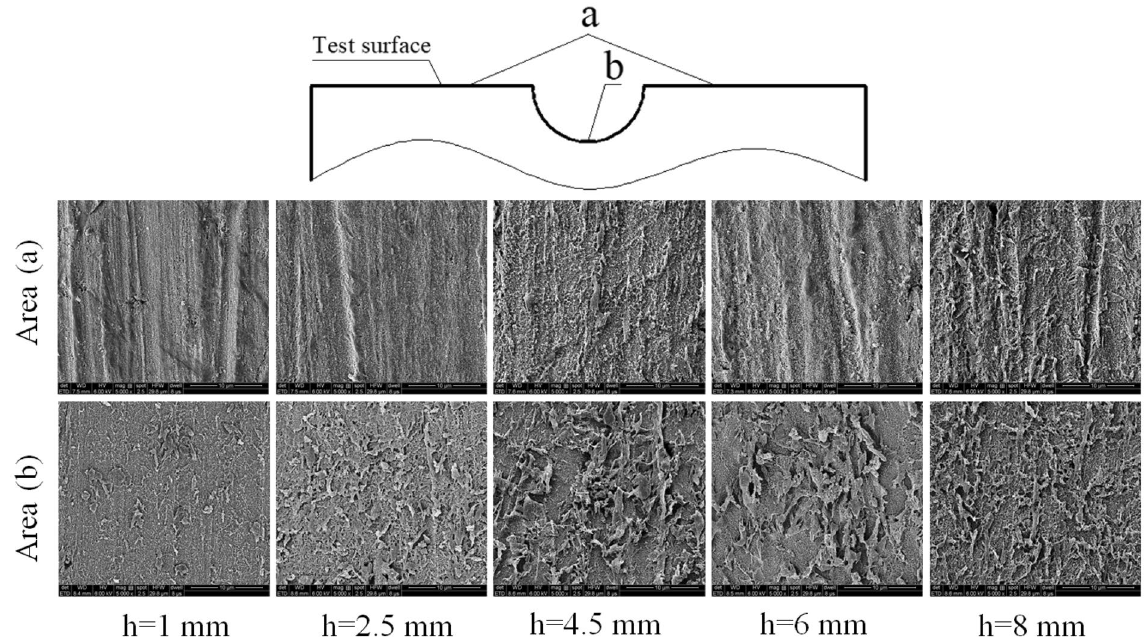
Figure 9. SEM of corrosion products in different